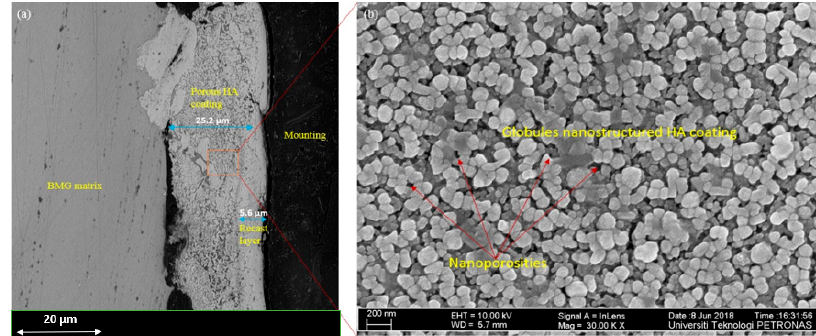
Figure 3. SEM micrograph showing: ( a ) cross-sectional micrograph of the coated Zr 67 Cu 11 Ni 10 Ti 9 Be 3 BMG by HAm-EDM process processed at P c = 8 A, D d = 8 µs, and C = 20 g/L and ( b ) magnified microstructural image showing the nanostructured and nanoporous hydroxyapatite (HA) coating.